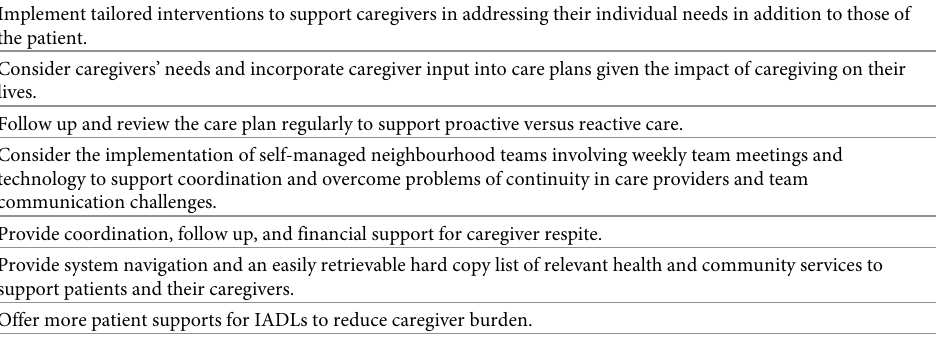
Table 5. Recommendations for caring for caregivers of patients who have complex care